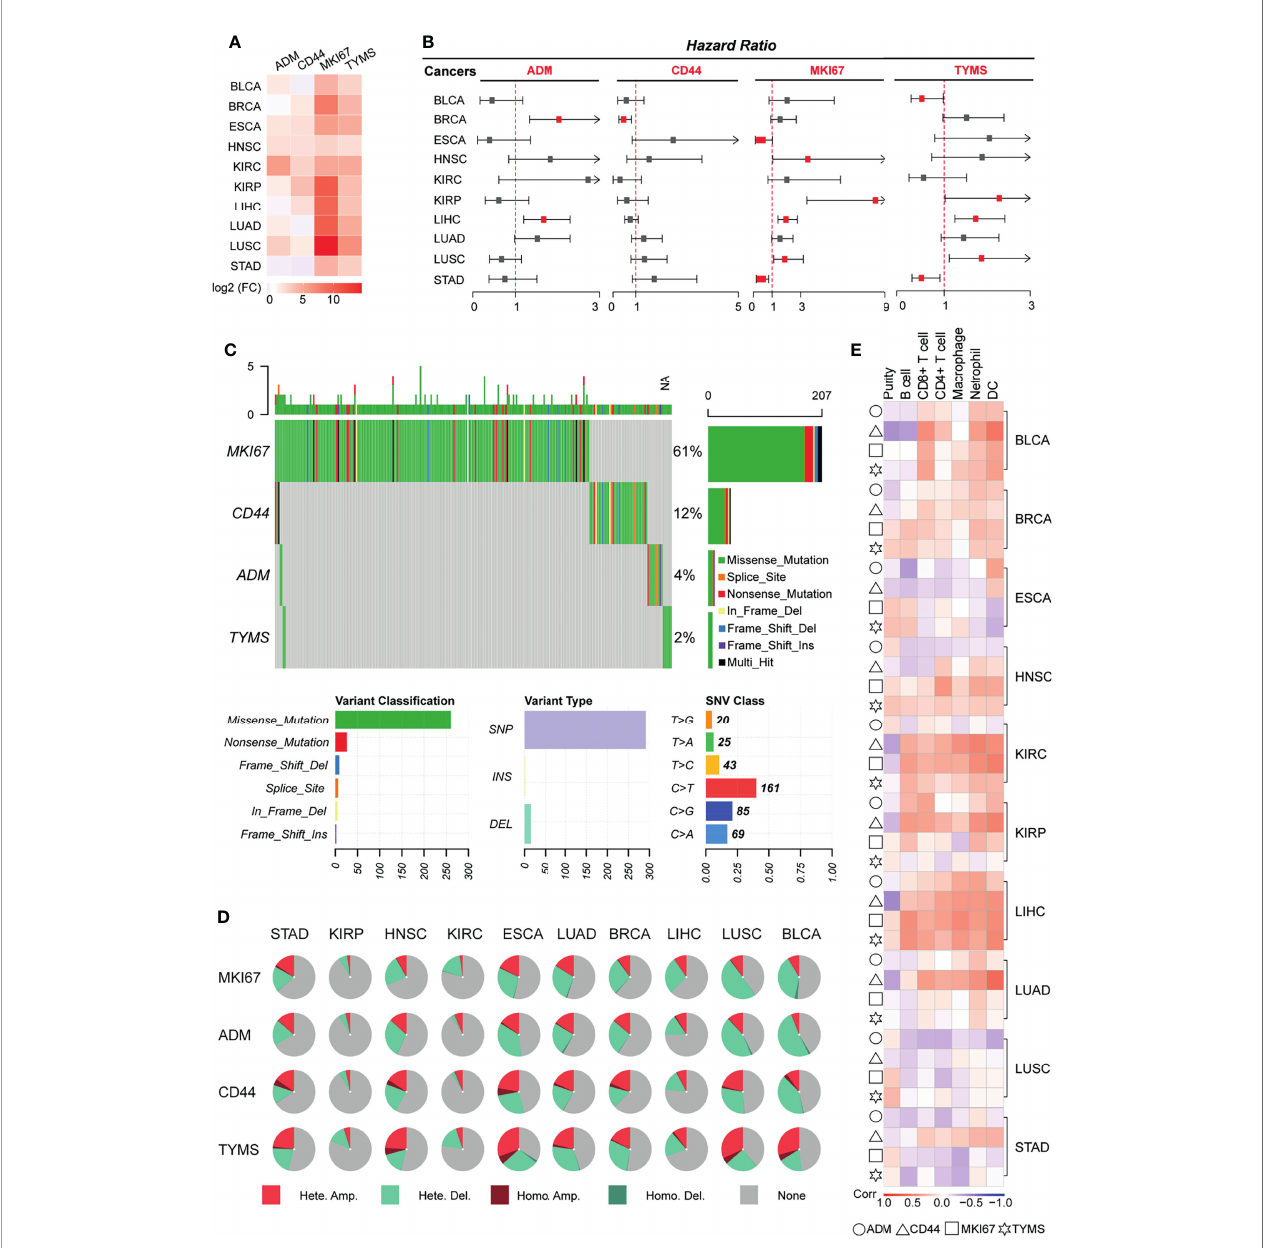
FIGURE 6 | Validating the generalizability of the GRS predictive models across cancers. Ten types of tumors were used for pan-cancer analysis, and the pan-cancer RNA-Seq data were downloaded from TCGA. (A) Heatmap displaying the mRNA levels of GRS genes in different cancers. (B) Univariate Cox regression analysis of the association between the risk of recurrence and GRS gene mRNA levels. (C) Waterfall plot showing the SNV mutation signatures of four GRS genes. (D) Pie charts displaying the CNV mutations of four GRS genes. (E) Correlation of the expression of four GRS genes with immune cell in fi